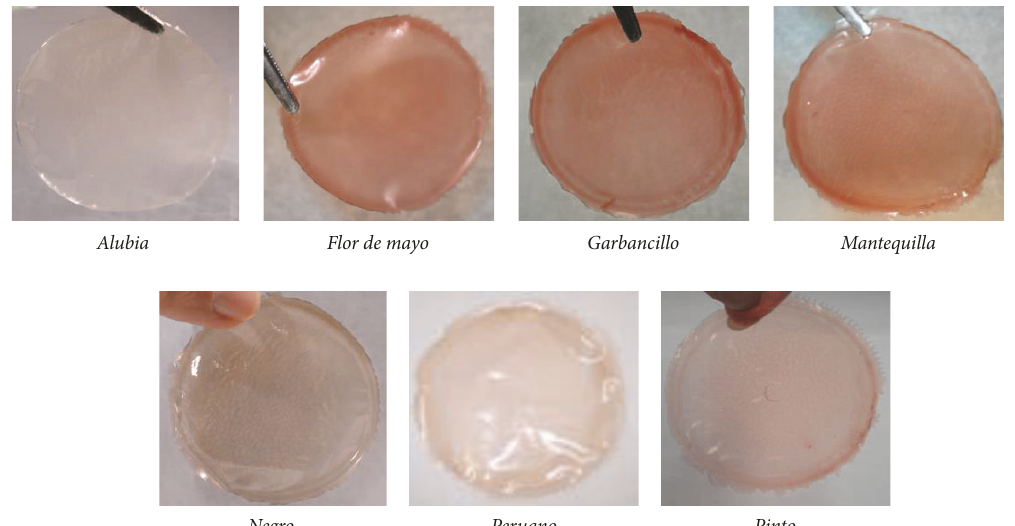
Figure 3: Color of proteinaceous edible films obtained from the studied bean varieties.